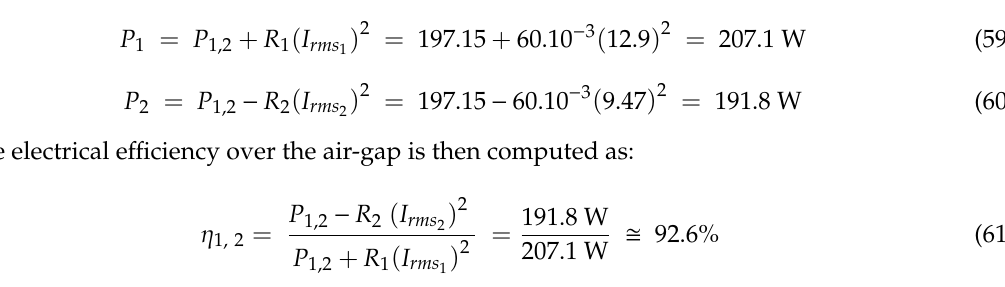
Figure 17. Power transfer boundaries in the simplified schematic of the implemented circuit.